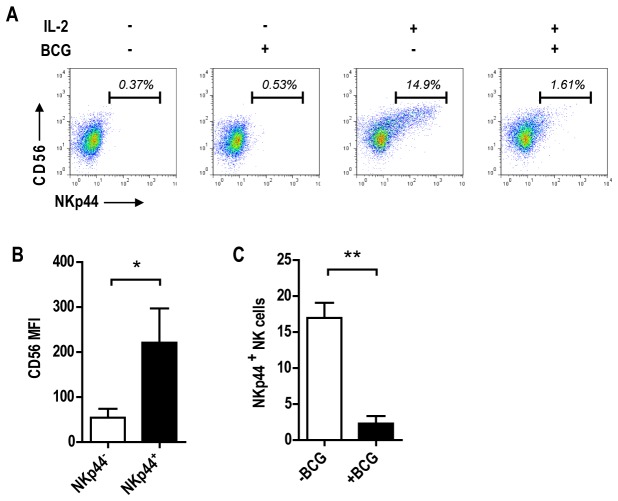
IL-2 induction of NKp44 expression on CD56bright NK cells
is inhibited by mycobacteria.A) FACS plot analysis of NKp44 expression from NK cells cultured in the
presence or the absence of IL-2 (100U/ml) and or M. bovis
BCG (MOI 1:5) for 5 days. B) Bar graphs showing B) significant increase
of CD56 MFI of the NKp44+ NK cell population and C)
significant decreased frequencies of IL-2 induced NKp44+ NK
cell in the presence of mycobacteria from three independent experiments
and donors (Paired t test, *p<0.05, **p<0.01).